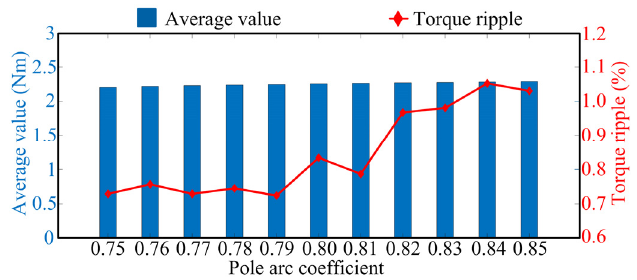
Figure 11. Effect of pole arc coefficient on electromagnetic torque in a machine with 4-pole and 33-slot.